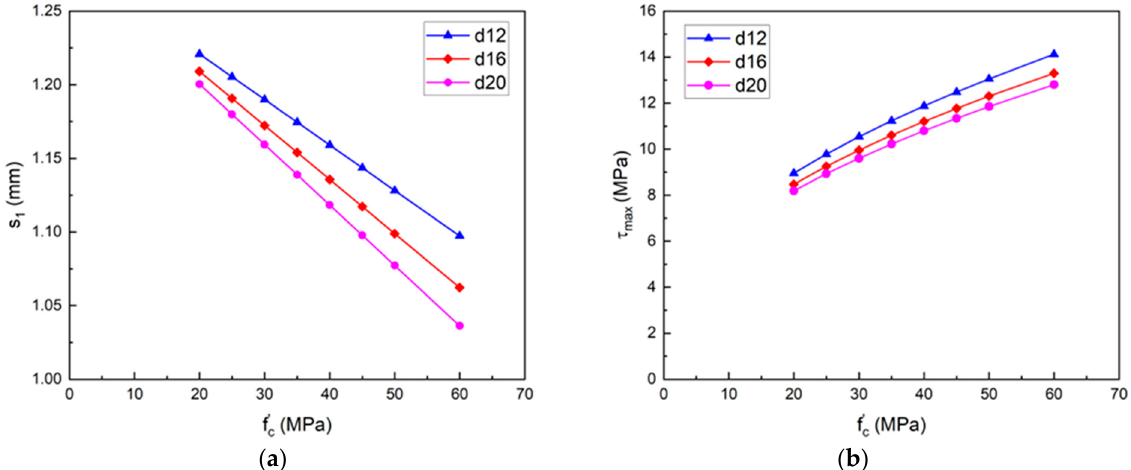
Figure 11. Influence of compressive strength on ( a ) bond strength and ( b ) corresponding slip.